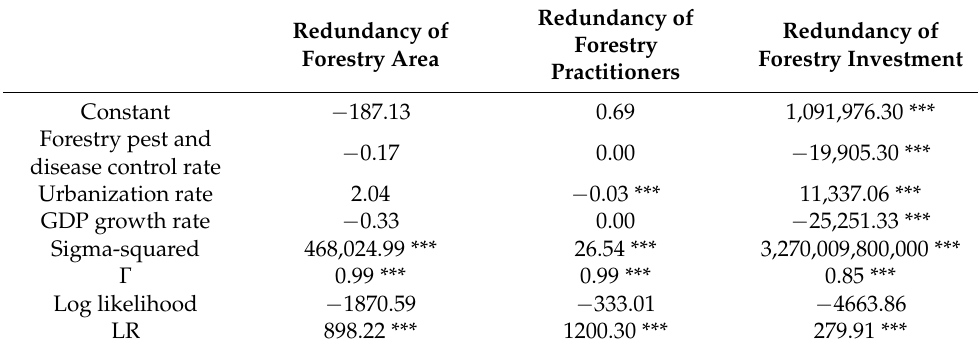
Table 1. SFA results of environmental indicators on input redundancy from 2009 to 2018. Redundancy of Redundancy of Redundancy of Forestry Forestry Investment Forestry Area Practitioners Constant − 187.13 0.69 1,091,976.30 *** Forestry pest and − 0.17 0.00 disease control rate Urbanization rate